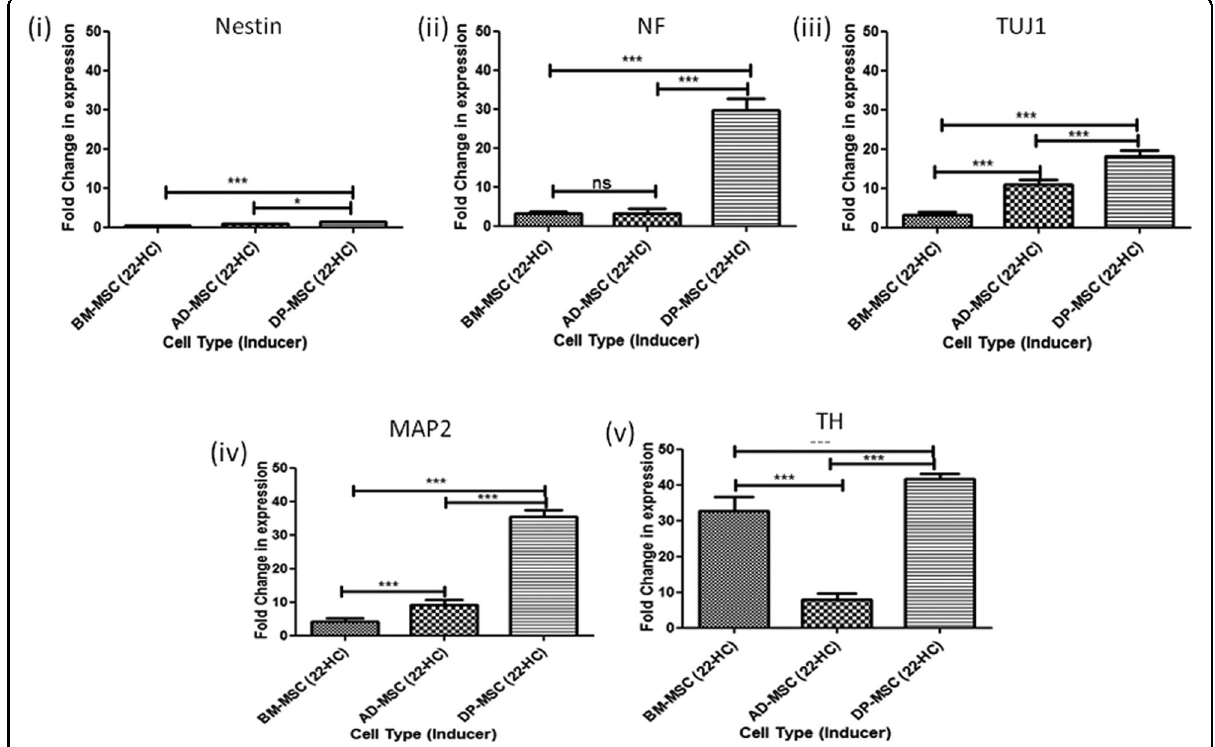
Fig. 2 qRT-PCR transcriptional analysis of differentiated hMSCs. (i) Relative fold change in mRNA expression of nestin in induced hMSCs, as compared to respective uninduced counterparts; (ii) relative fold change in mRNA expression NF in induced hMSCs, as compared to respective uninduced counterparts; (iii) relative fold change in mRNA expression of TUJ1 in induced hMSCs, as compared to respective uninduced counterparts; (iv) relative fold change in mRNA expression of MAP2 in induced hMSCs, as compared to respective uninduced counterparts; (v) relative fold change in mRNA expression of TH in induced hMSCs, as compared to respective uninduced counterparts. Data points represent the means ± SD ( n = 3), * p < 0.001 vs. control untreated